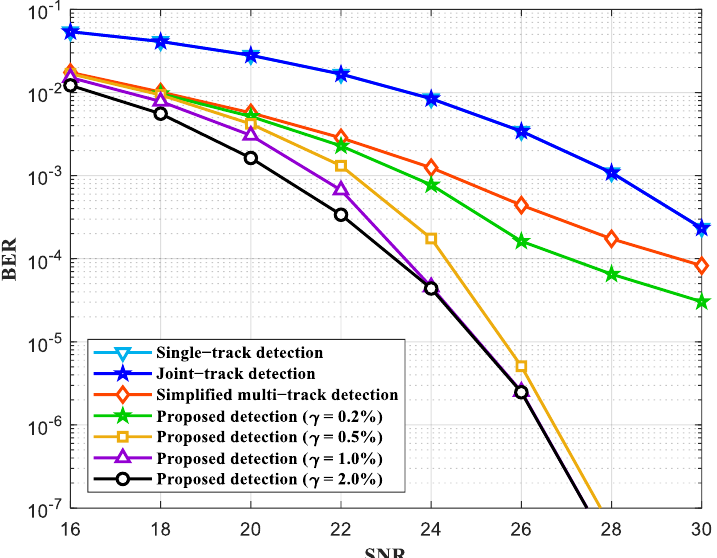
Figure 4. BER performances for the various detection schemes with 0% TMR when an areal density is 3.5 Tb/in 2 .